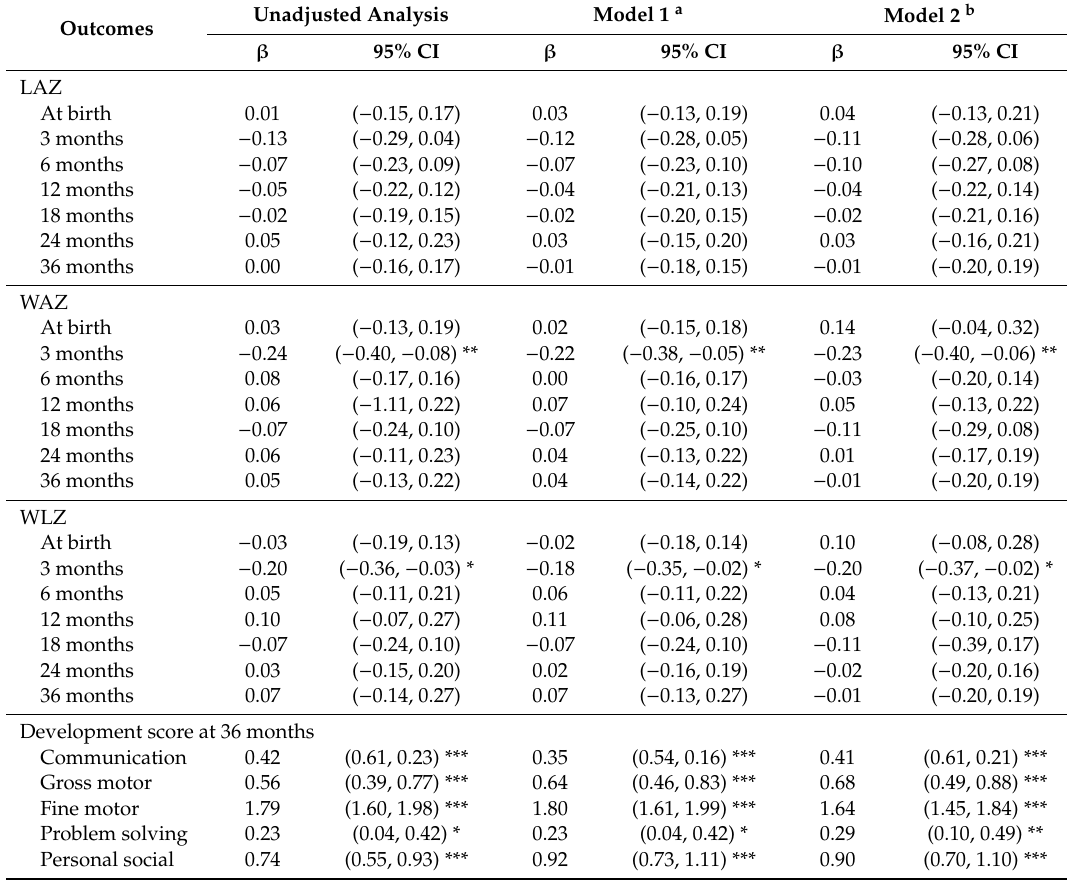
Table 2. E ff ects of maternal prenatal multi-micronutrient supplementation compared with iron–folic acid supplementation on infant linear growth and development score at di ff erent age